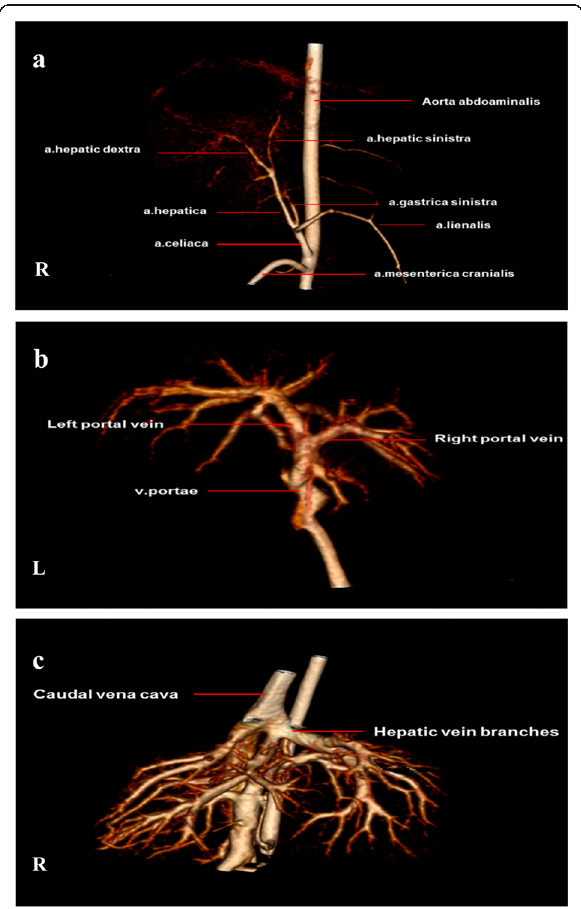
Fig. 6 VR images of hepatic vascular anatomy at different delay times in cats. ( a ) The arterial phase, ( b ) the portal phase and ( c ) the hepatic parenchymal